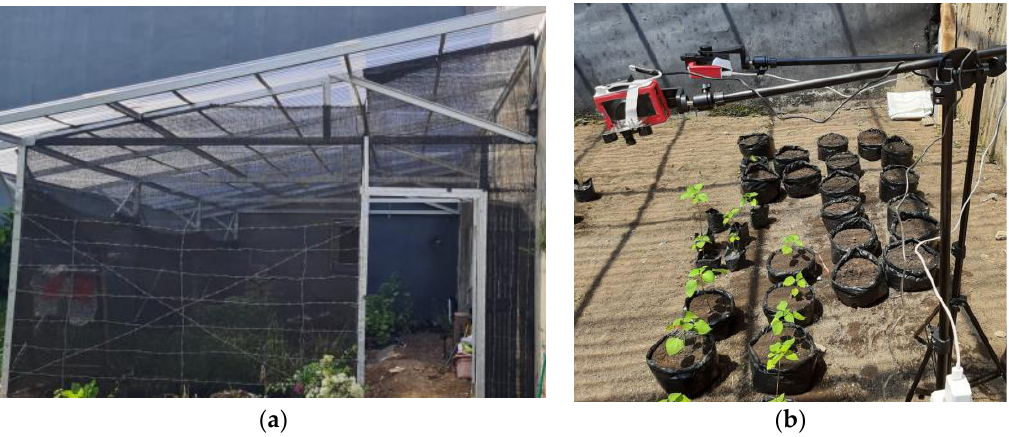
Figure 1. ( a ) Greenhouse; ( b ) Ramie plant and camera installation.